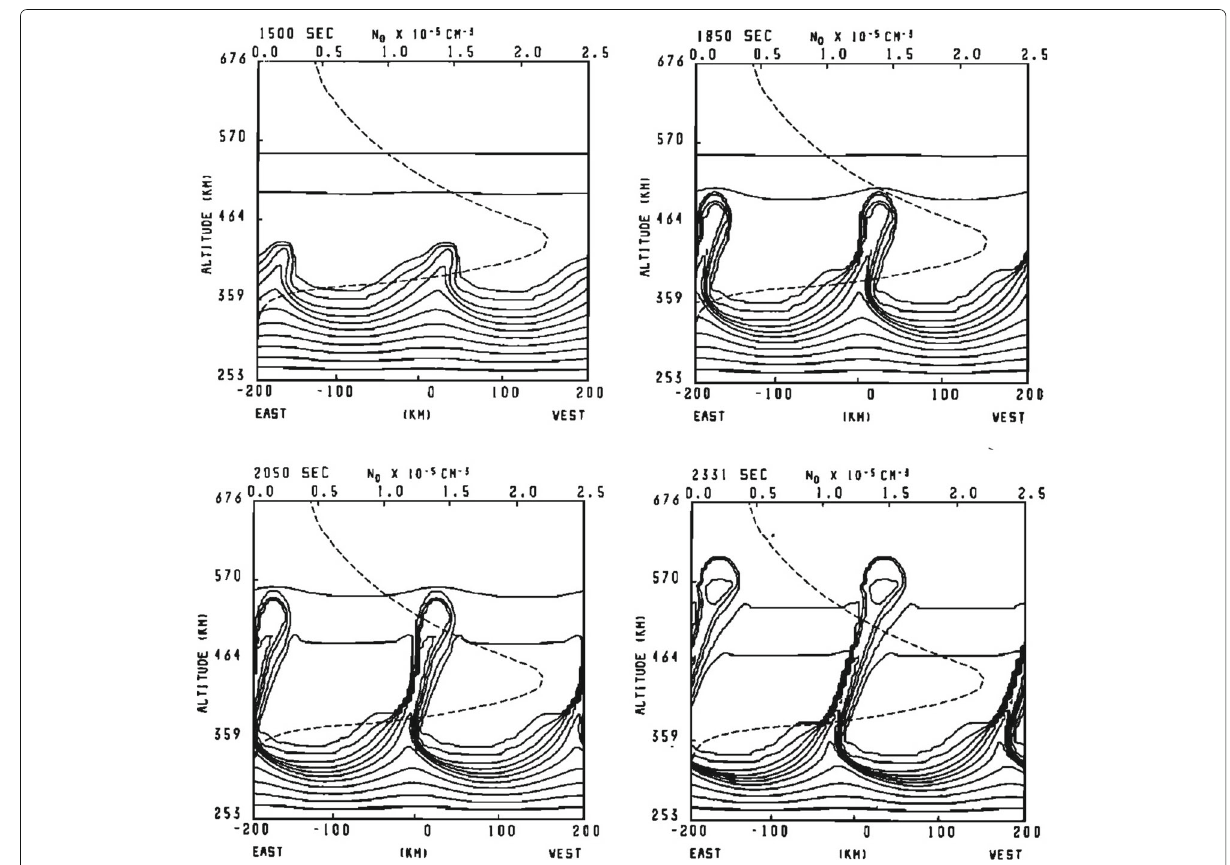
Fig. 3 EPBs tilted by neutral wind effects. Reproduced from Zalesak et al.